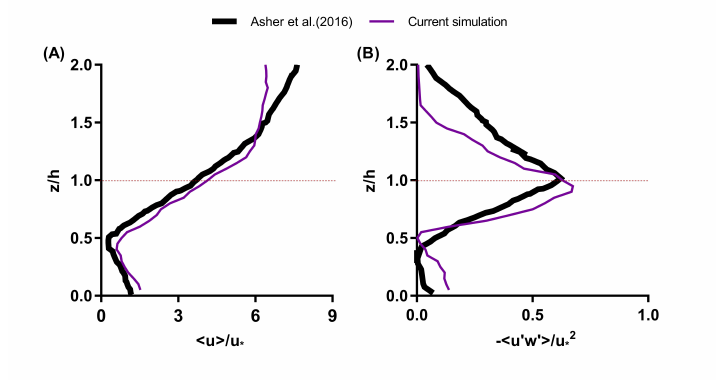
Figure 4. Comparison of ( A ) the normalized streamwise velocity and ( B ) Reynolds stress over a single P. meandrina colony from the current simulation with the experimental results over 81 P. meandrina colonies at Re = 23,513 by Asher et al. [20]. The dotted line represents the top of the colony. The experimental data were obtained using GRABIT in MATLAB [52] and reproduced with permission from Asher et al. Vertical variations of coral reef drag forces. Journal of Geophysical Research: Oceans 2016 , 121 , 3549–3563. For both data sets, the mean velocity and Reynolds stress were normalized by the friction